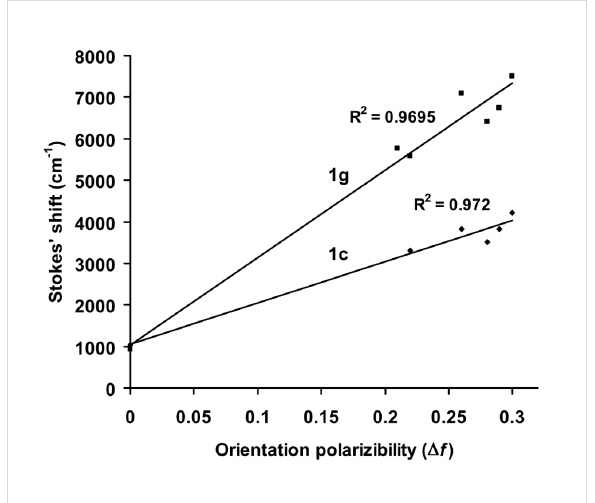
tronic excitation ( μ ES − μ GS ) was estimated assuming the mole- cular radius as the cavity radius [11]. The molecules under consideration are non-spherical in nature. Hence, the above assumption of substituting molecular radius for cavity radius is only approximate. The molecular radii for 1c (8.8 Å) , 1e (10.2 Å) and 1g (9.1 Å) were obtained from semi-empirical AM1 calculations [46]. The change in the dipole moments ( Δμ ) were, 25.7 D for 1c , 43.0 D for 1e and 40.0 D for 1g , respectively (Table 1). The change in dipole moment for 1g is higher than that of the corresponding pyrene derivative (30 D)